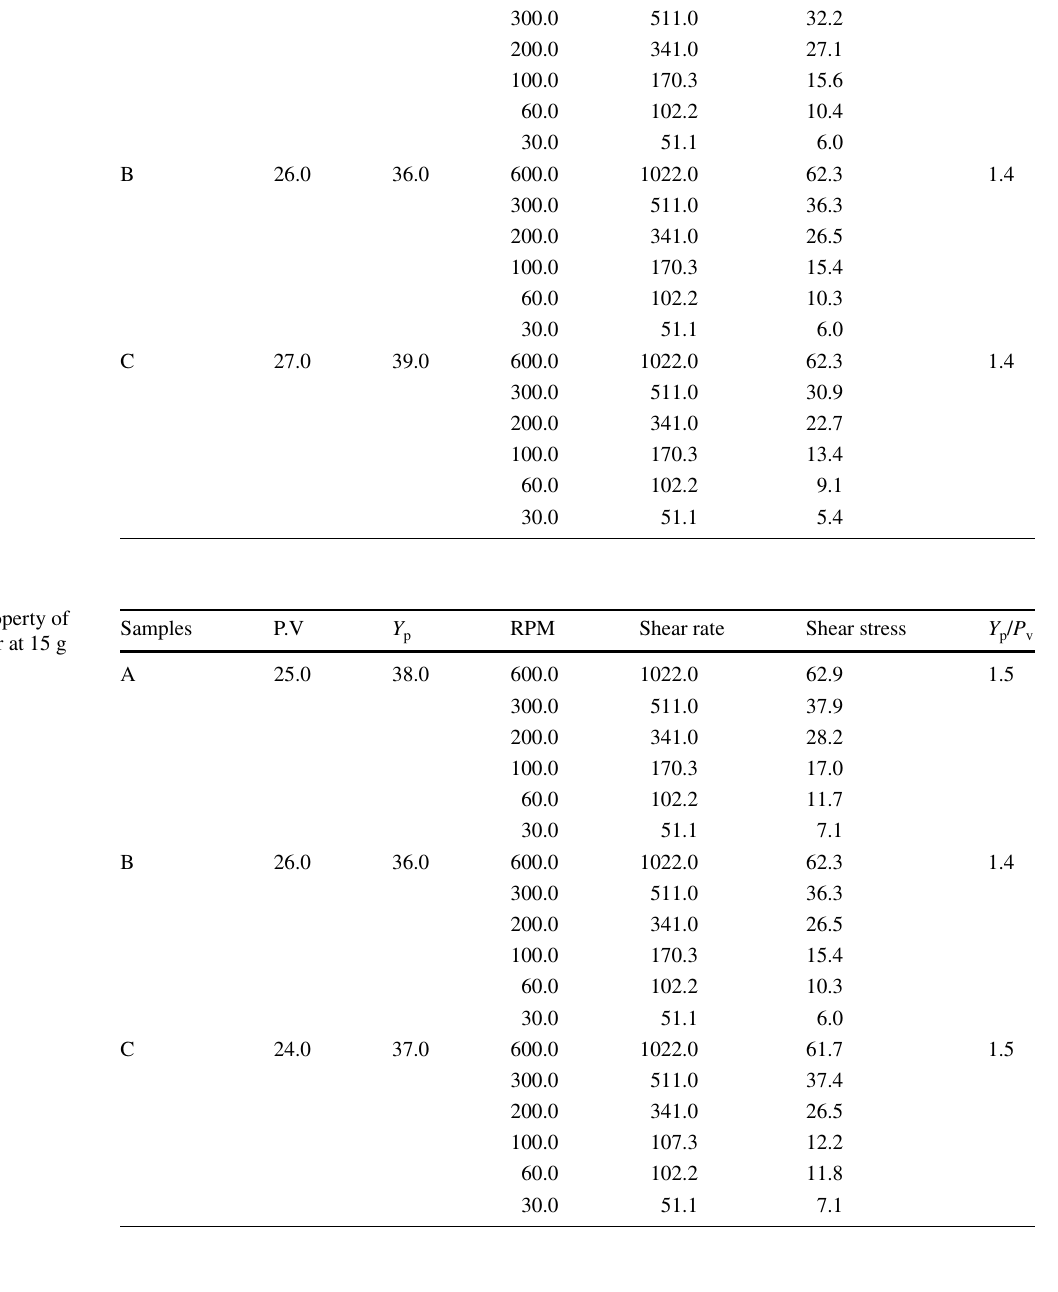
Table 18 Evaluation of V V s and T.E using 5